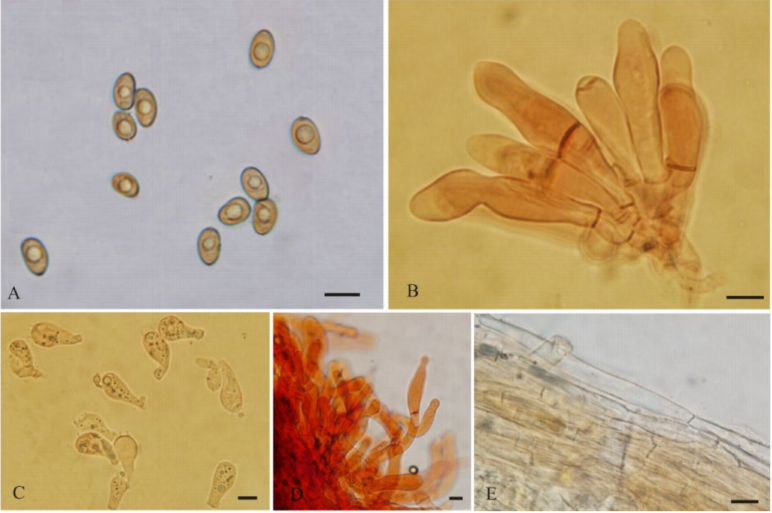
Figure 8. Pseudosperma pseudoniveivelatum (BJTC FM1660) ( A ) Basidiospores, ( B ) Cheilocystidia, ( C ) Basidia, ( D ) Caulocystidia, ( E ) Pileipellis. Scale bars: ( A – E ) = 10 µ